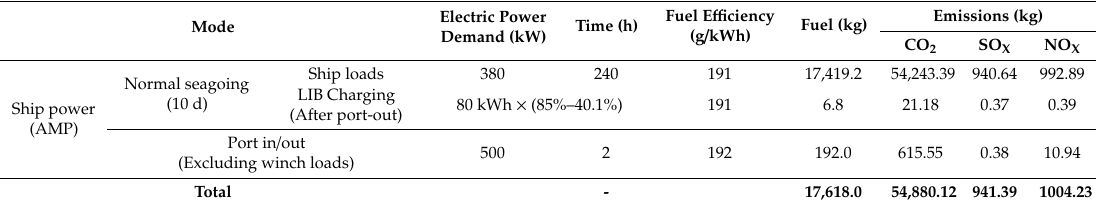
Table 14. Emissions from onboard gensets for each mode (proposed system).